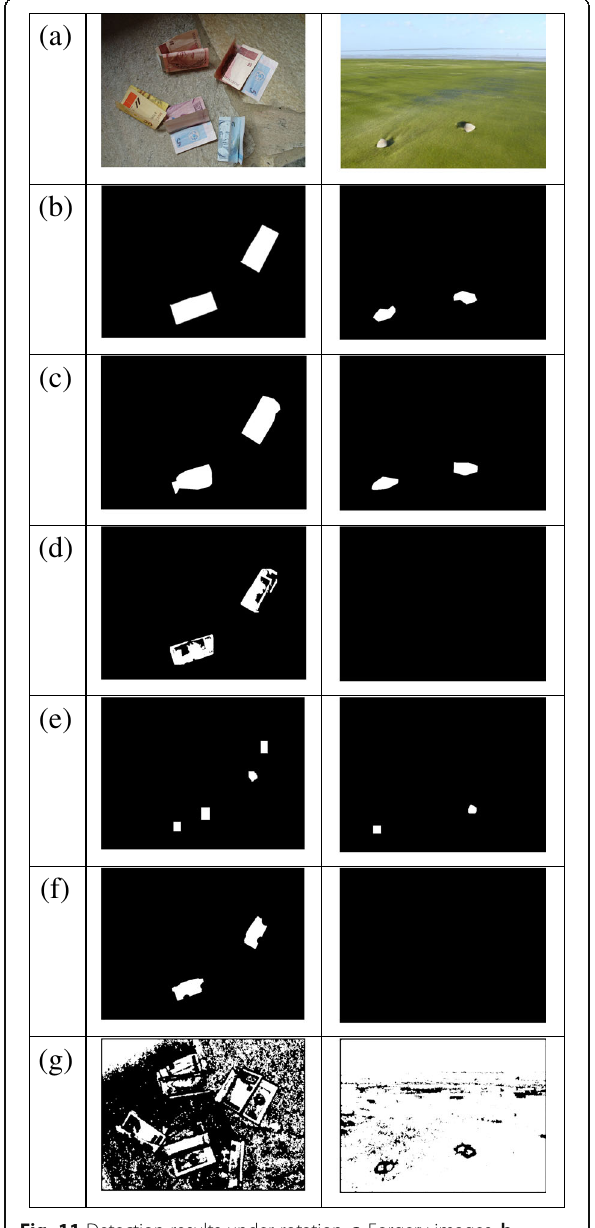
Fig. 11 Detection results under rotation. a Forgery images. b Ground truth. c Our proposed. d Amerini et al. [13]. e Silva et al. [16]. f Pun et al. [18]. g Li et al.